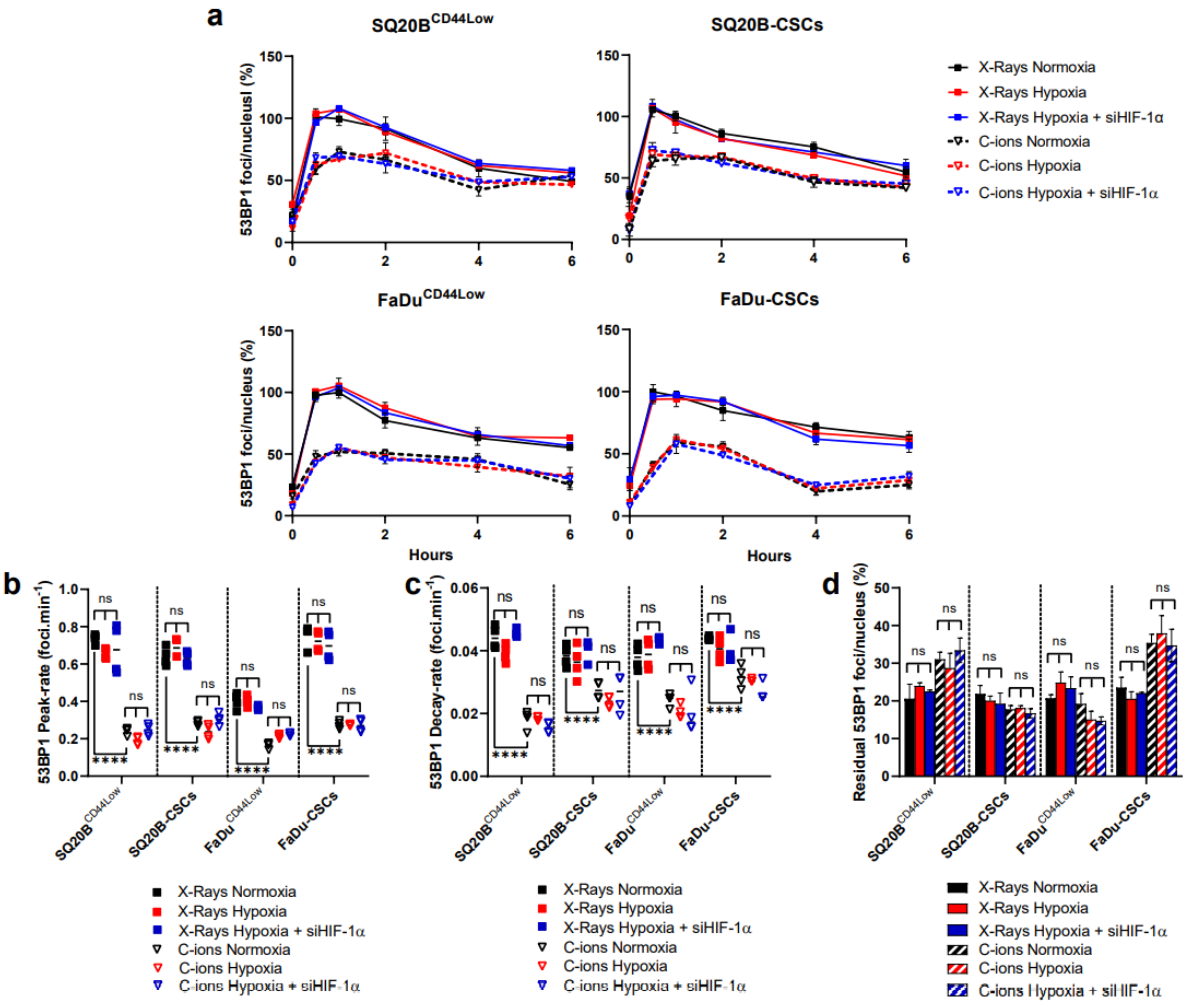
Figure 4. HIF-1 α silencing does not impact 53BP1 levels of foci. ( a ) Kinetics of 53BP1 foci after X-Rays and C-ions ± siHIF-1 α . The percentages of foci per nucleus were calculated for each condition considering the X-Ray normoxic peak as the reference (means ± SD). ( b , c ) represent respectively the 53BP1 peak-induction from the basal levels and the decay-rate from the peak to 6 h, as determined from the data shown in ( a ). ( d ) Residual foci were quantified at 24 h and each condition was compared to their respective normoxic condition (two-way ANOVA test, ns = non-significant). ( n = 3 photons; n = 2 C-ions).